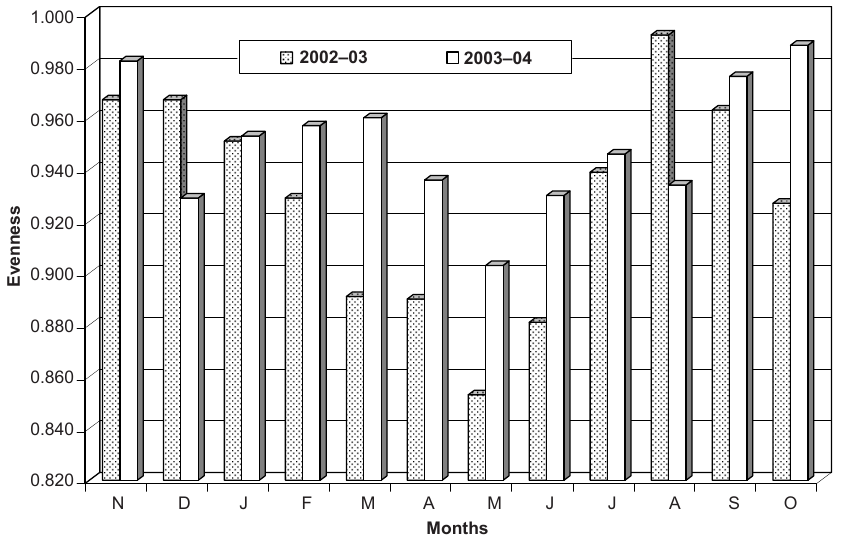
Figure 9. Monthly variations in evenness of